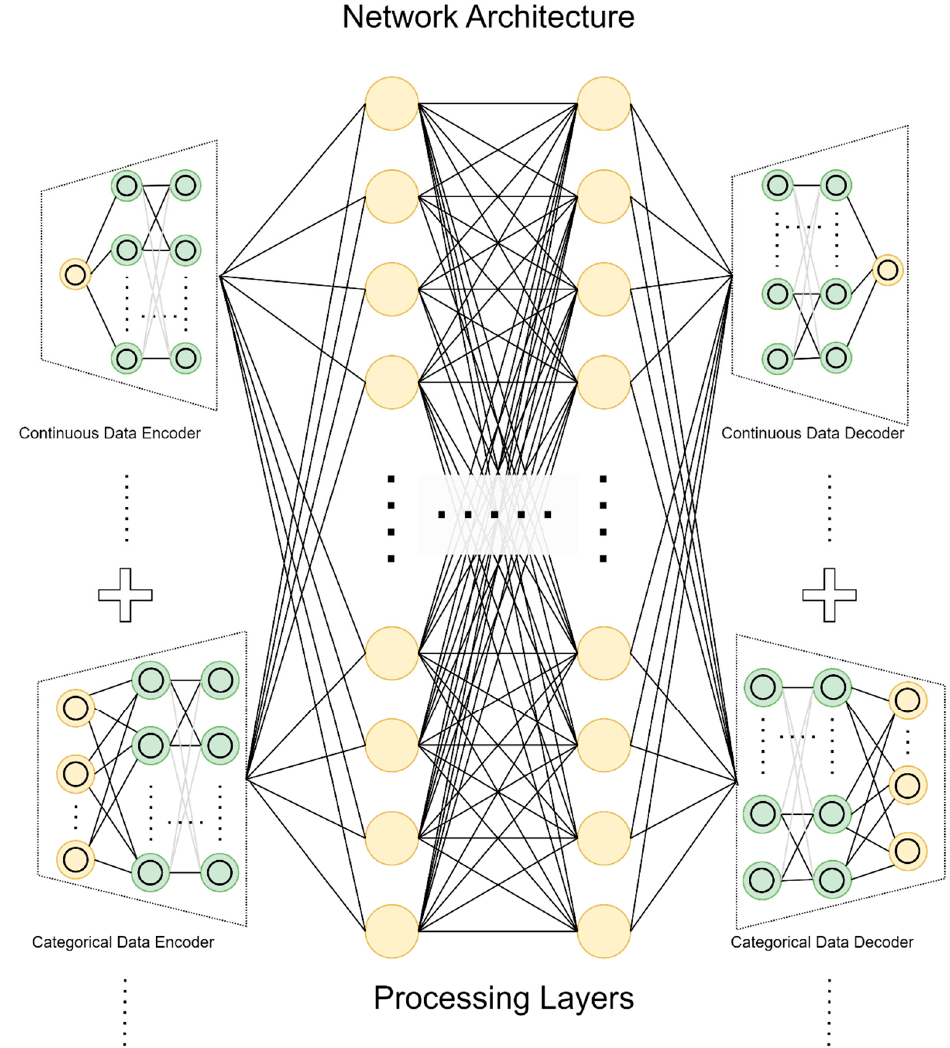
Figure 5. Network Figure 5. Network architecture.